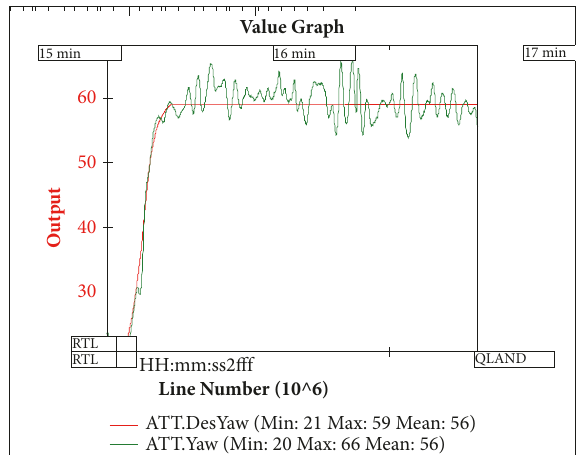
Figure 15: The yaw and desired yaw in